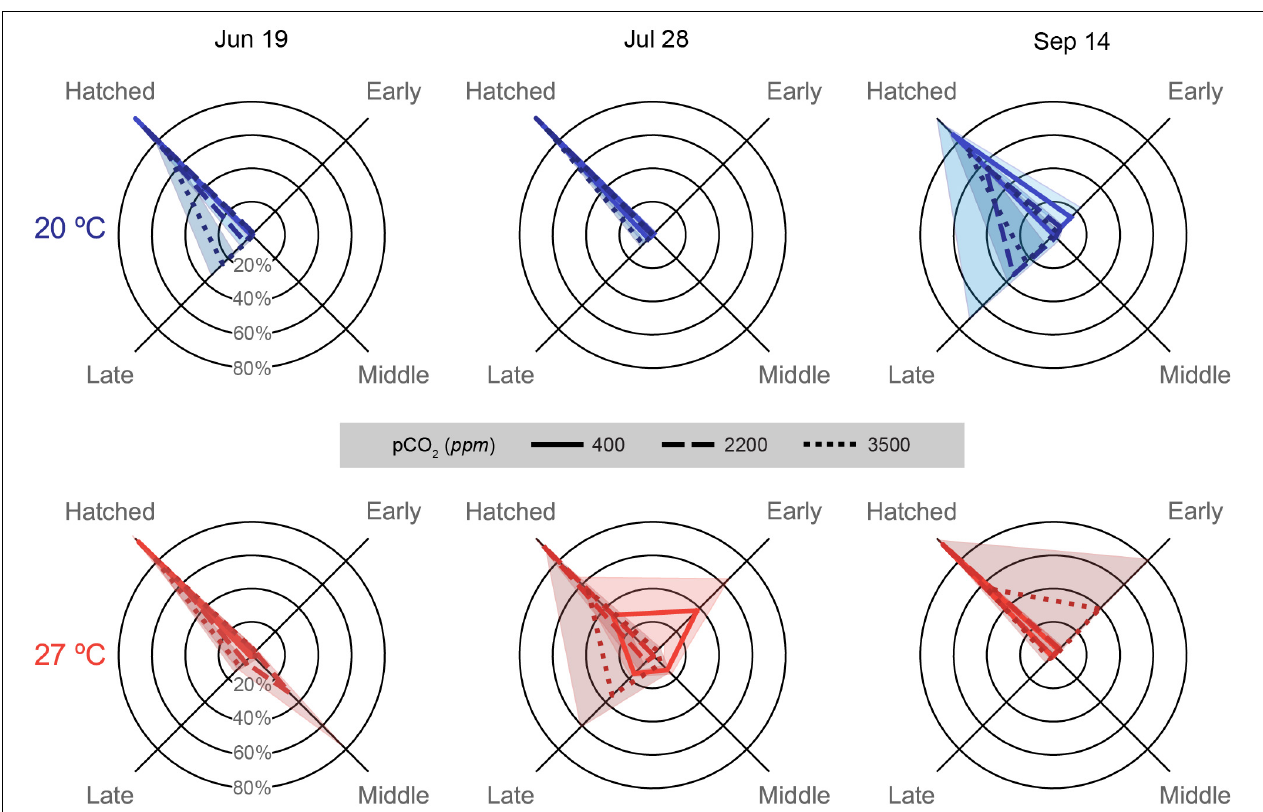
FIGURE 6 | Embryonic survival data depicted for each trial (column title) on spider plots: axes represent categorical variables, while rings represent proportions of embryos in each category (labeled in June 19 plots). Categories include, clockwise from top left, Hatched: embryos that successfully hatched from the egg capsules (includes premature and malformed hatchlings), and embryos that ceased development either Early: Arnold stages 1–16, Middle: Arnold stages 17–26, or Late: Arnold stages 27–30 (Arnold et al., 1974). Lines represent means, while shading represents one standard deviation. Line patterns and shade of color represent acidification treatments (smaller hash/darker color = more acidic). Plot position and data coloration represent temperature treatment (top/blue = 20 ◦ C, bottom/red = 27 ◦